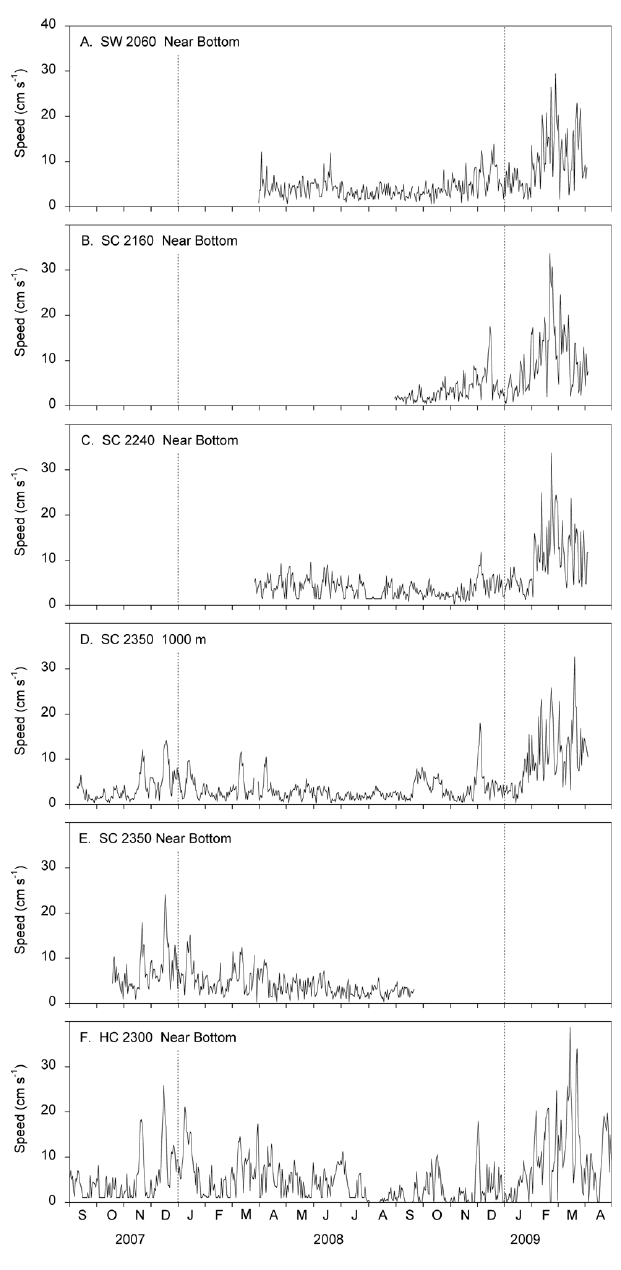
Fig. 6. Time series of current magnitude at few tens of meters above seabed at SW2060 (A) , SC2160 (B) , SC2240 (C) , SC2350 (E) and HC2300 (F) , and at mid-depth at SC2350 (D) from September 2007 to April 2009.